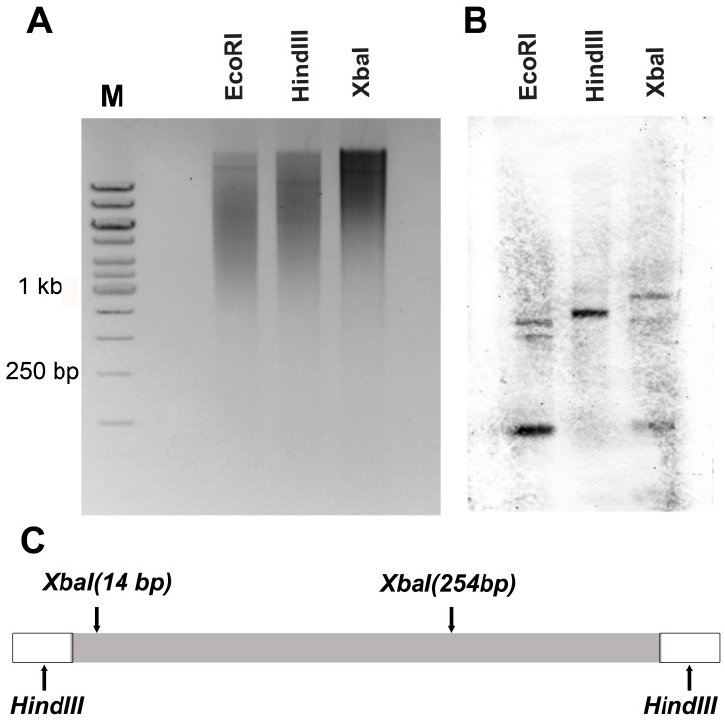
Figure 2. Electrophoresis in 0.8% agarose gel ( A ) and Southern blot ( B ) with CR1-rng probe on H. elongata DNA, digested with the indicated restriction endonucleases. ( C ) Restriction map of CR1- rng. Grey box—CR1-rng sequence, white boxes indicate flanking sequences, containing HindIII sites. M—DNA ladder; bp—base pairs; kb—kilobase